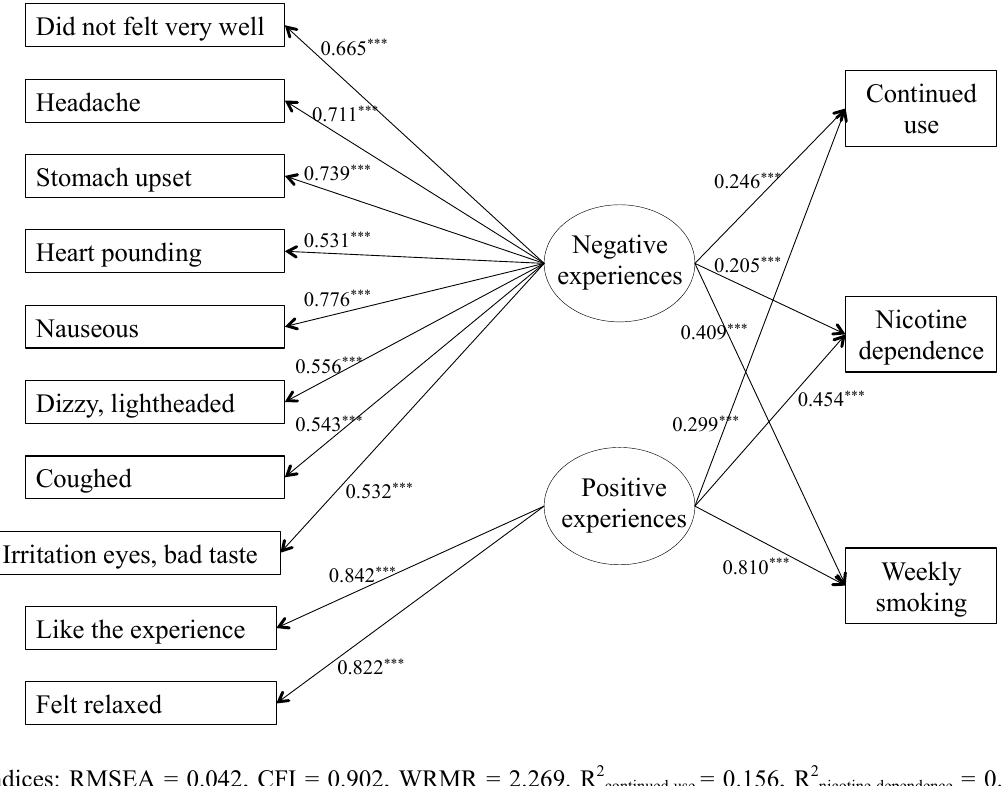
Figure 2. SEM for two-factor